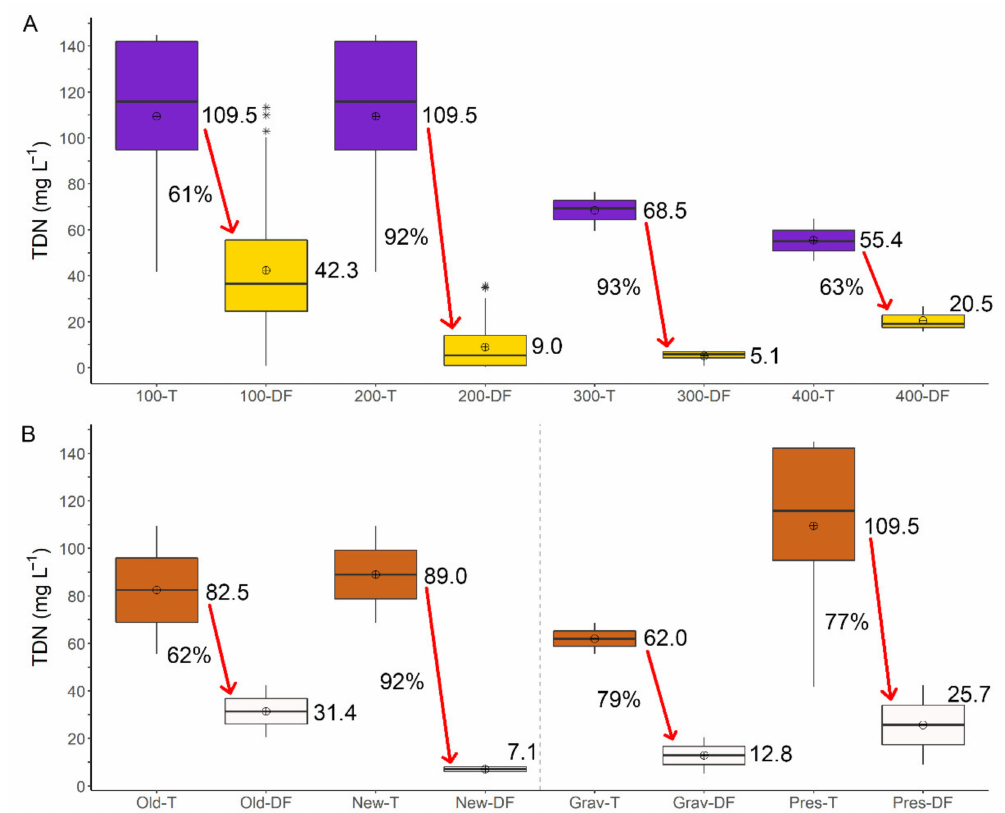
Figure 2. Box plots showing total dissolved nitrogen (TDN) concentrations in septic tank effluent (T) and groundwater near (<3 m) the drainfield trenches (DFs) at each site ( A ). Figure ( B ) shows old (>10 years) and new (<1 year) and gravity (Grav) and pressure (Pres) dosed comparisons of TDN concentrations in wastewater and groundwater. Mean percent concentration reductions are shown as percentages. Circles indicate mean concentrations, horizontal lines show median concentrations, asterisks are statistical